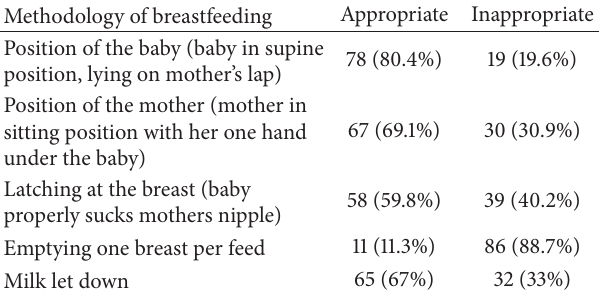
Table 5: Methodology of breastfeeding ( 𝑛 = 97